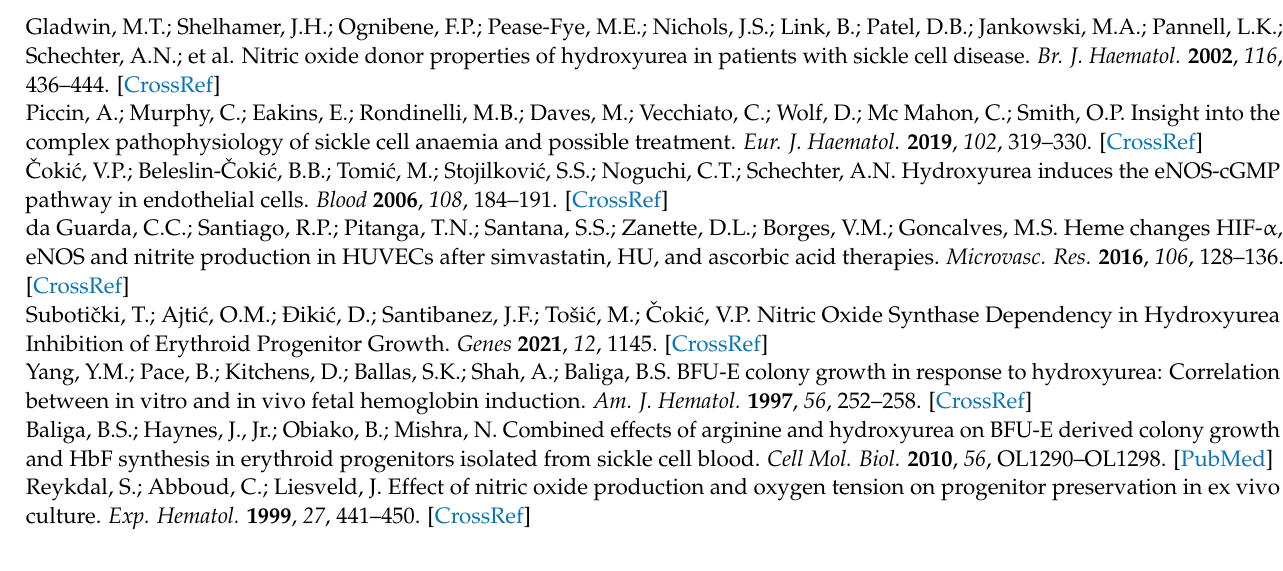
cells, Figure S2: Immunocytochemistry of CFU-E colonies, Figure S3: Immunocytochemistry of BFU-E/CFU-GM